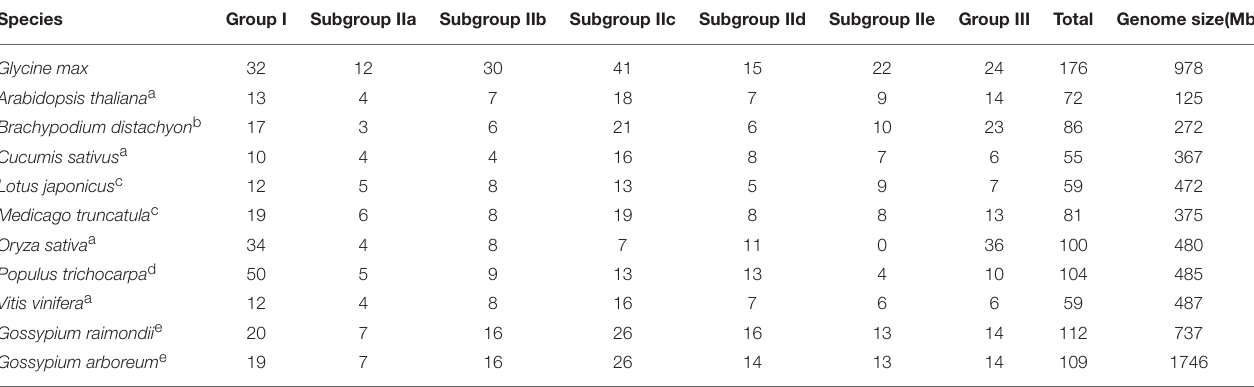
TABLE 1 | Number of WRKY genes identified in